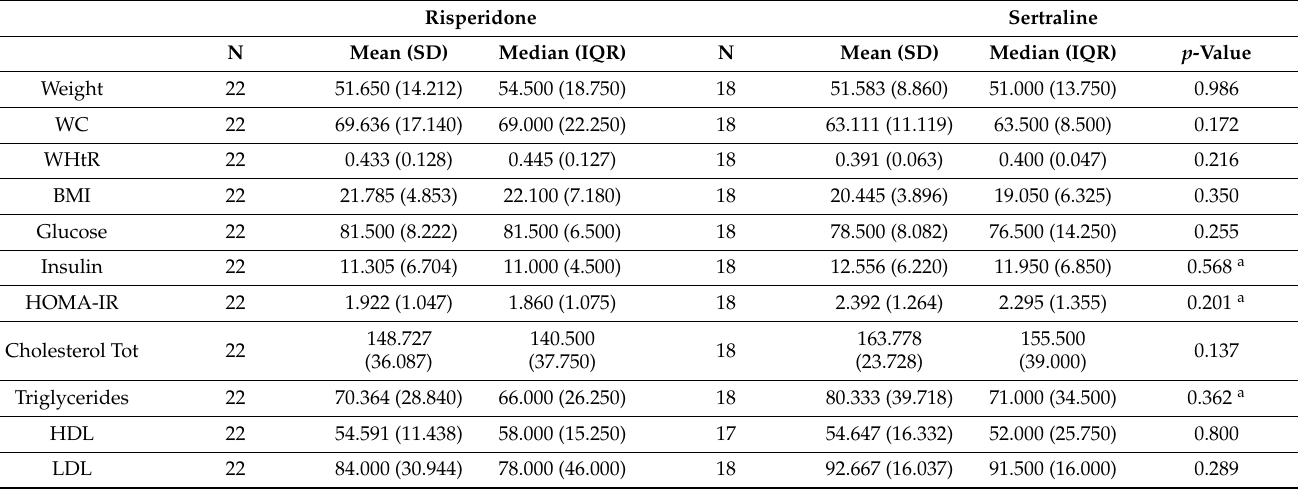
Table 2. Baseline comparisons of the anthropometric and metabolic parameters between the two groups.